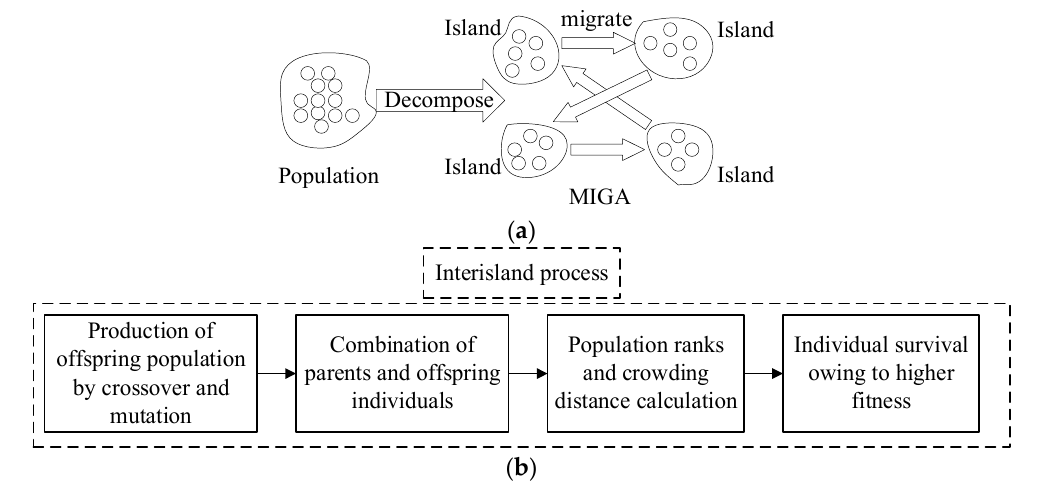
Figure 15. The structure and process of the multi-island genetic algorithm (MIGA) optimization method: ( a ) Structure, ( b ) Process.